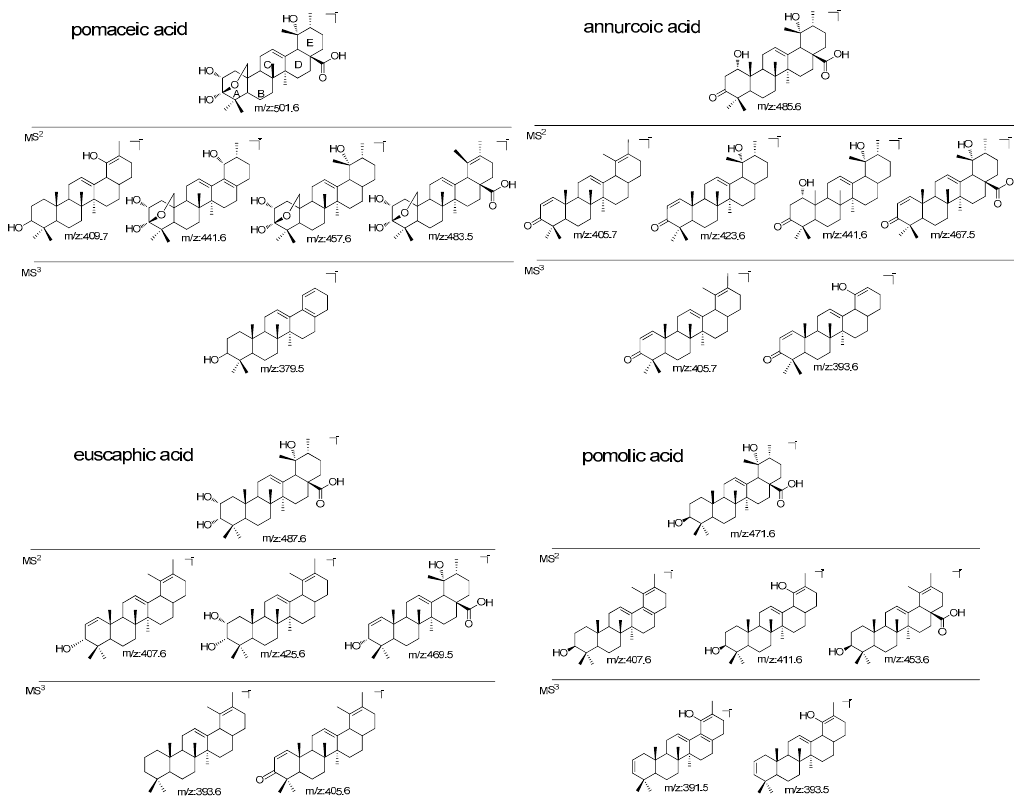
Figure 2. Tentative structures proposed for the main fragment ions of pomaceic, annurcoic, euscaphic and pomolic acids in the MS n study.